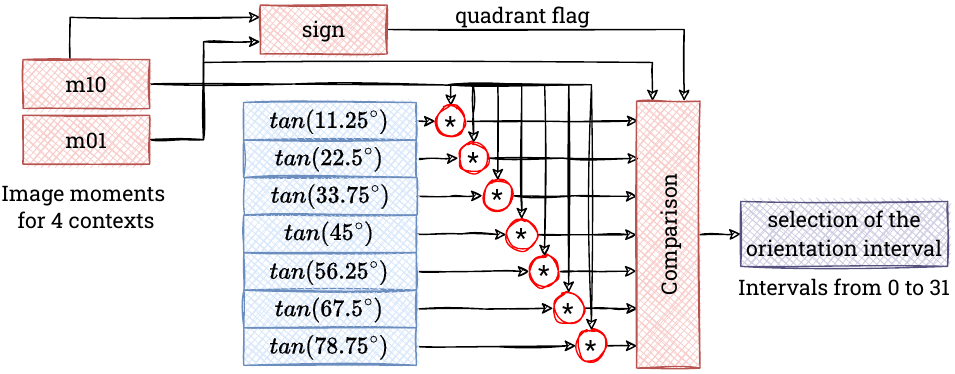
Figure 9. Scheme of the mechanism for determining the orientation by assigning a value to an appro- priate